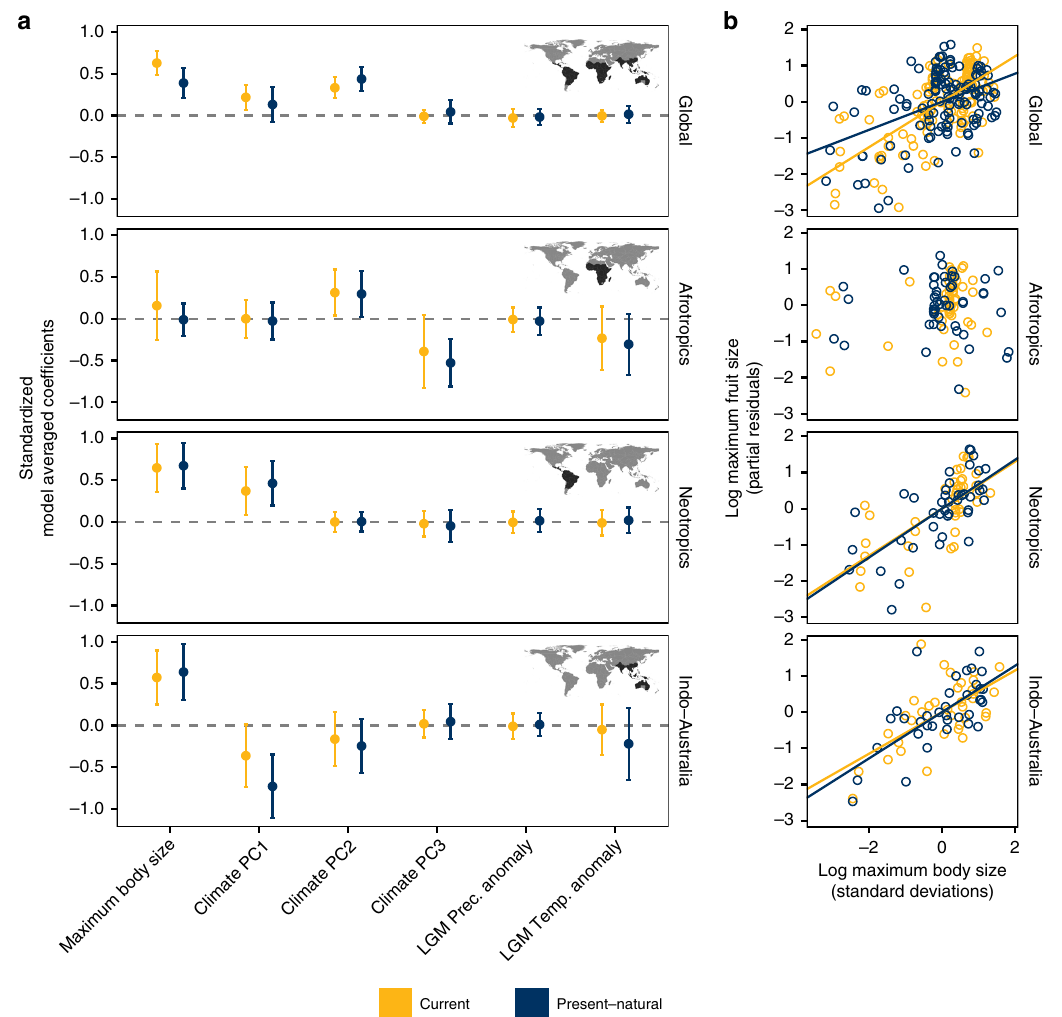
Fig. 2 Relationship between maximum fruit sizes of palms and maximum body sizes of frugivorous mammals. Different colors represent scenarios using current mammal assemblages (yellow) and Pleistocene assemblages that include extinct frugivores (dark blue). All maximum values are based on 95th percentiles. In a , relative effect sizes (standardized coef fi cients) of maximum body size as well as several current and paleoclimatic predictors on patterns of maximum palm fruit size at global and regional scales are indicated by dots. Bars on each dot represent 95% con fi dence intervals. Spatial extent of individual analyses is highlighted in inset maps through dark shading. Standardized coef fi cients were obtained through model averaging of ordinary least- squares (OLS) models with all possible combinations of predictor variables for each scenario. In b , partial residual plots show the relationships between maximum fruit and body size of mammalian frugivores globally and for each biogeographic region separately. Lines represents the model-averaged effect of maximum body size on maximum fruit size for each faunal scenario. Source data are provided as a Source Data fi